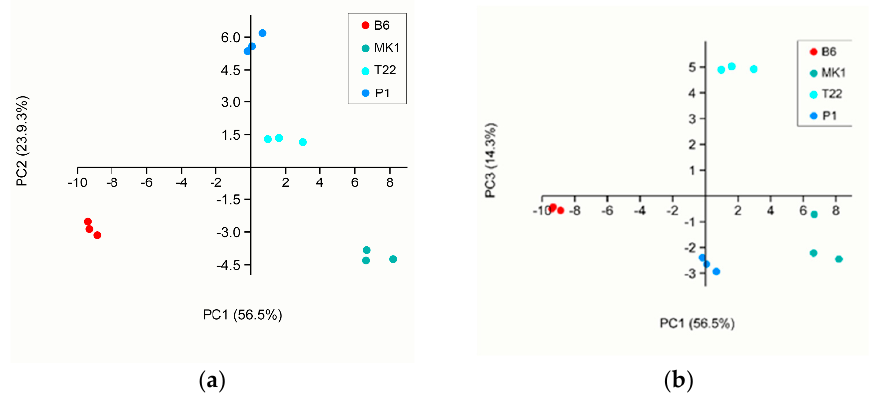
Figure 3. First three components of the PCA analysis of the PTR-Qi-TOF-MS data of VOCs emitted by samples grown on PDA: ( a ) PC1 and PC2 plot; ( b ) PC1 and PC3 plot. The variance explained by each component is reported in